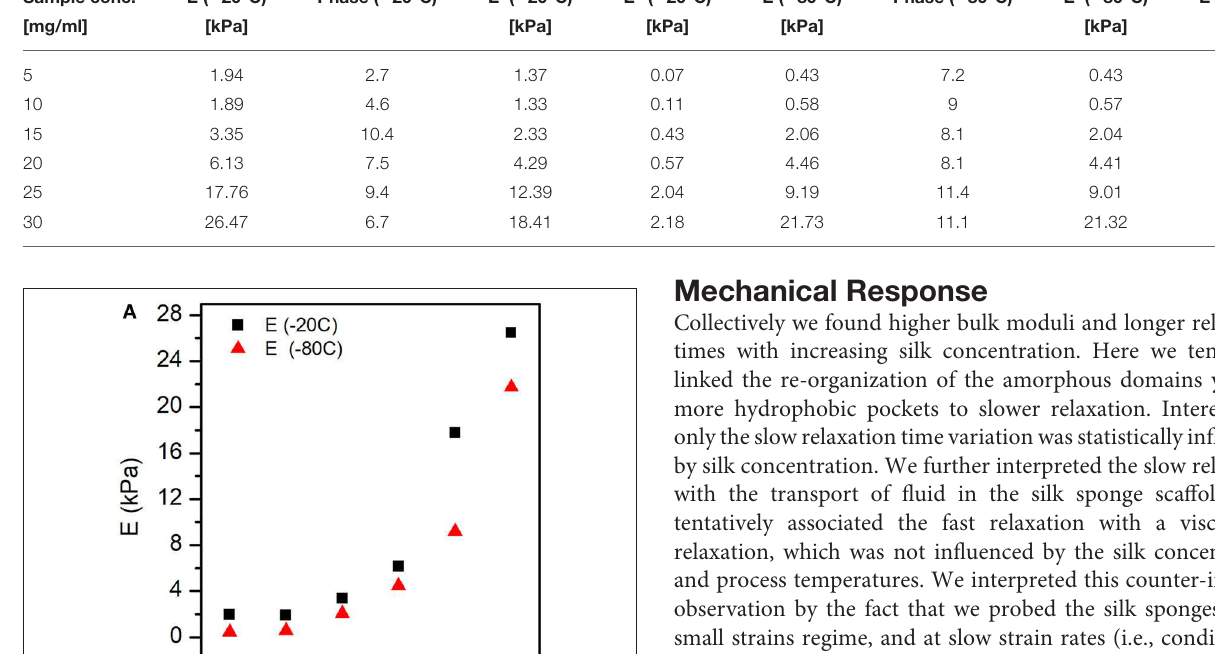
TABLE 7 | Elastic modulus (E), Storage modulus (E’) and Loss modulus (E”) obtained for the different sponges from the dynamical mechanical test. Sample conc.